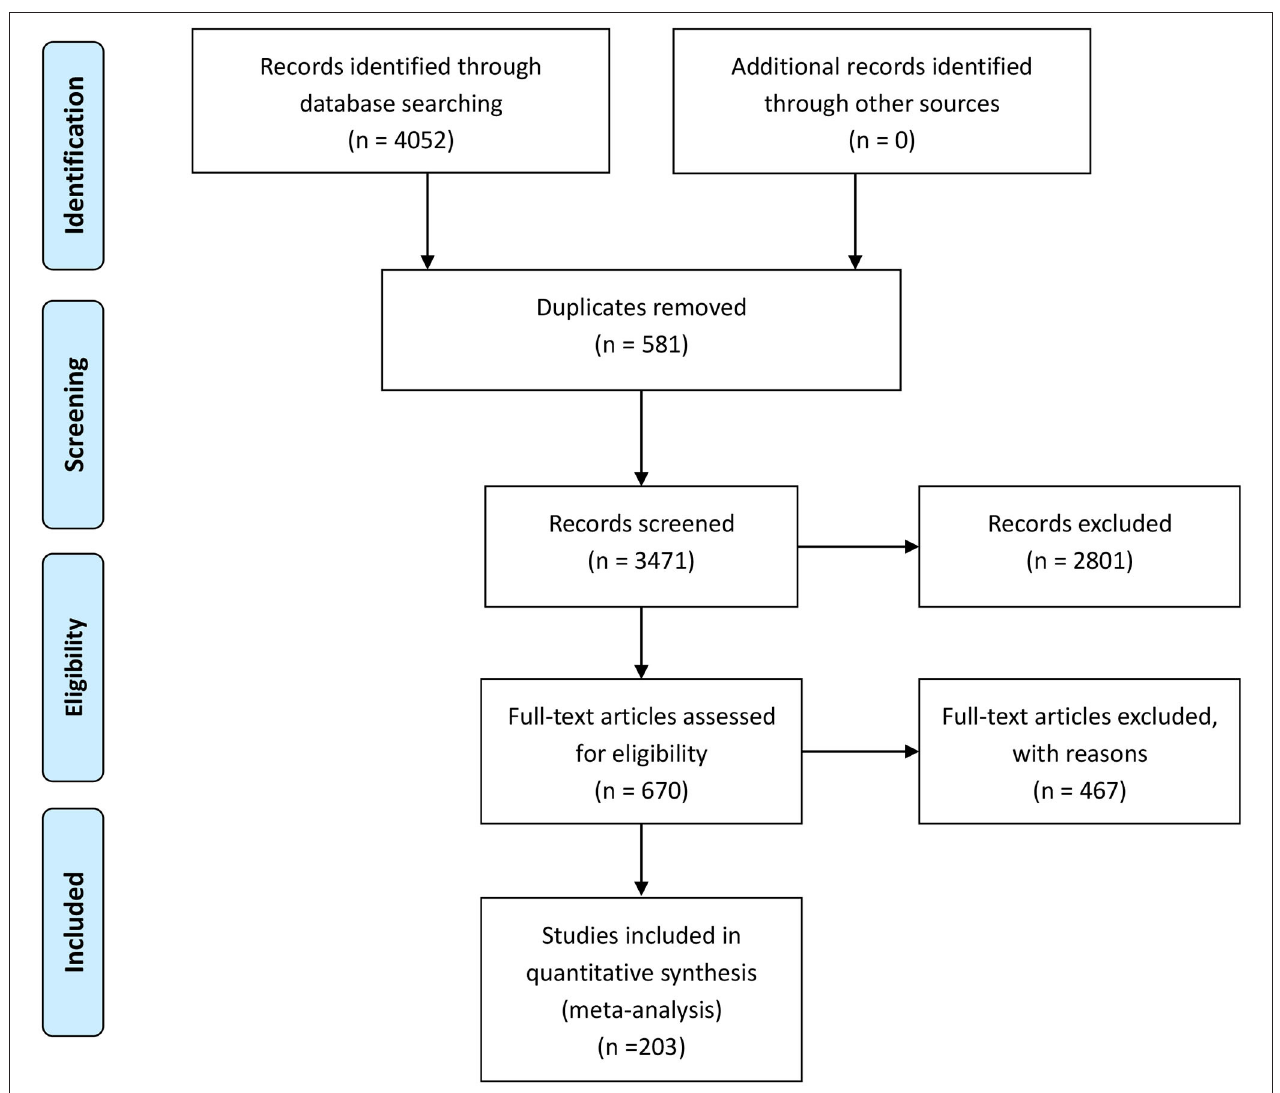
FIGURE 1 | Search results and flowchart of the